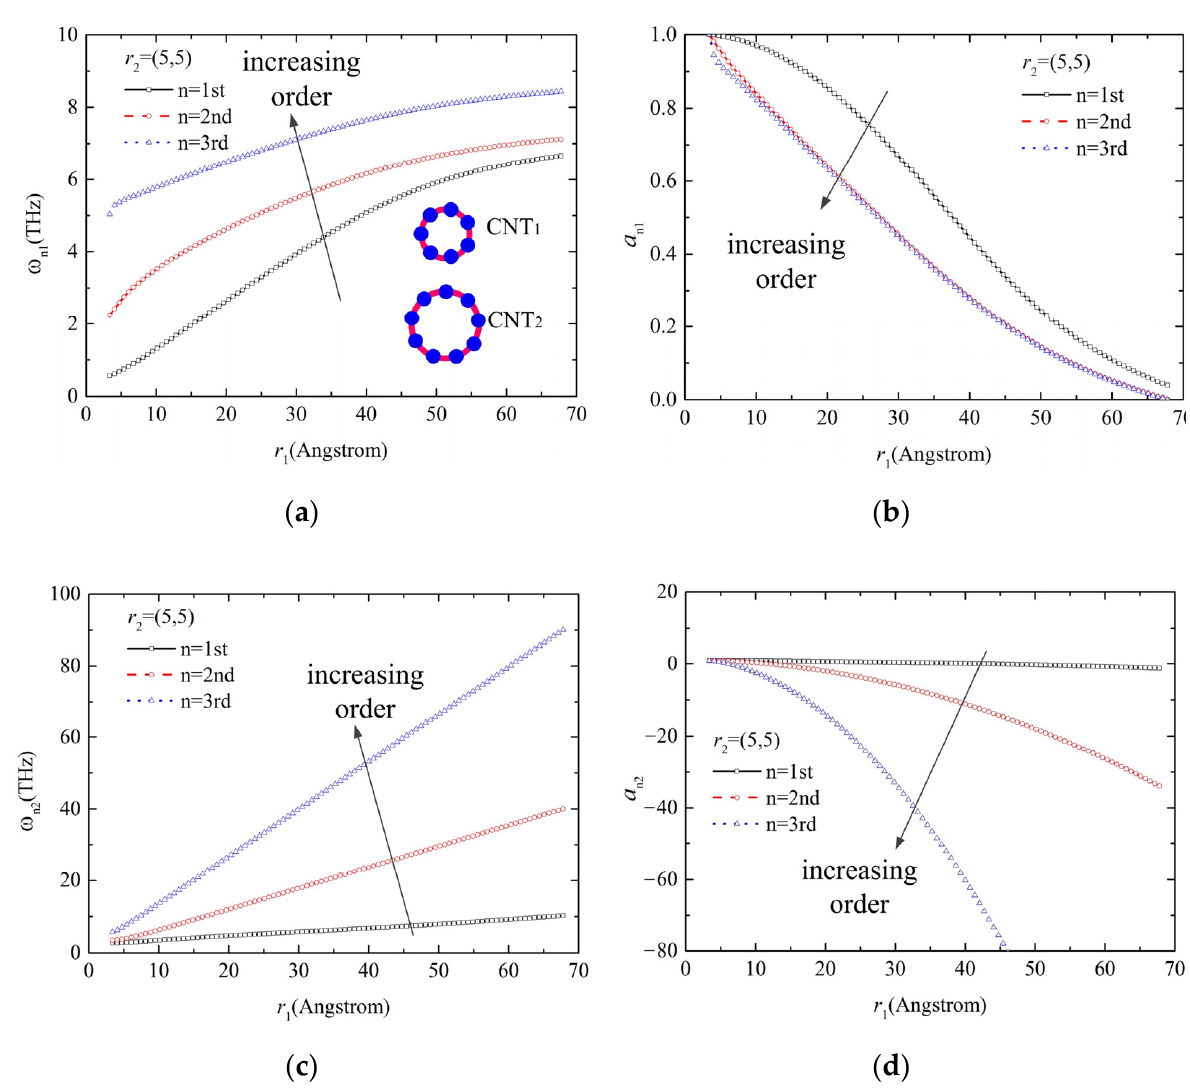
Figure 7. Effect of order on the vibration of CNTs with different diameters: ( a ) the increasing tendency for the resonant frequency with the increase in order under low frequency, ( b ) the decreasing dependence of amplitude ratio on the order under low frequency, ( c ) the increasing tendency for the resonant frequency with the increase in order under high frequency, ( d ) the decreasing dependence of amplitude ratio on the order under high frequency.